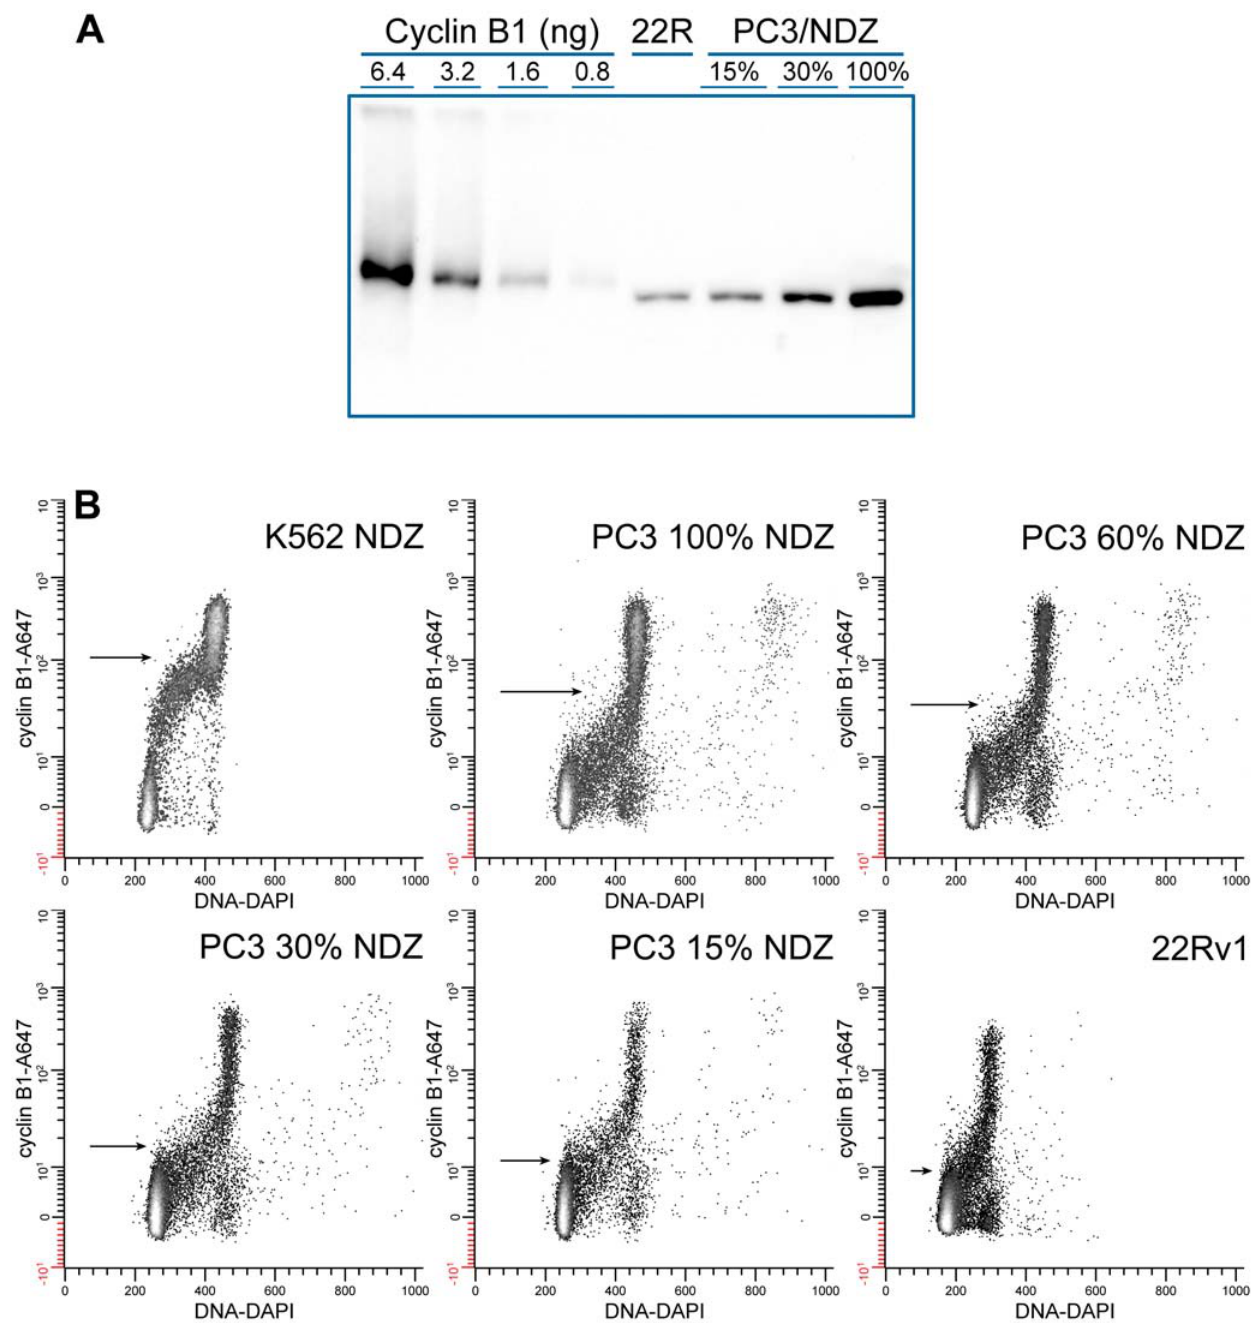
Figure 5. Cytometry and quantitative Western blots of standards. ( A ) Left 4 lanes are recombinant cyclin B1 at two-fold dilutions. Recombinant cyclin B1 and lysate concentrations were adjusted so that the band intensities for recombinant cyclin B1 spanned the range of those of the lysates. Trypsin inhibitor was added to each sample to bring the total protein per lane to 50 m g. ( B ) Lyophilized standard cell preparations from the same samples as used for Western blot were stained for cyclin B1 with GNS1-Alexa Fluor 647 (A647) and DNA (DAPI). Arrows indicate the mean cyclin B1 fluorescence. Background fluorescence was subtracted and data were plotted as a hyperlog transformation which allows plotting of negative and zero values on a linear lower section ( 2 10 to 10) and higher values ( . 10) logarithmically [22]. a narrow range of intensities to accommodate the narrow linear regression. The band intensity, the number of cells per lane, the range of X-ray film. For cyclin B1 we used direct chemilumines- regression slope and intercept, and the molecular weight of cyclin cence detection with the FluorS MultiImager, which is linear over B1 were then used to calculate the average number of cyclin B1 3 orders of magnitude, so a wide range standard curve could be molecules per cell for each standard cell lysate (Table 1). From 3 to generated. The relationship between band intensity and the 5 determinations were made for each cell line. The average amount of cyclin B1 applied to each lane was determined by linear coefficient of variation (CV) for all of the cell lines in the Western